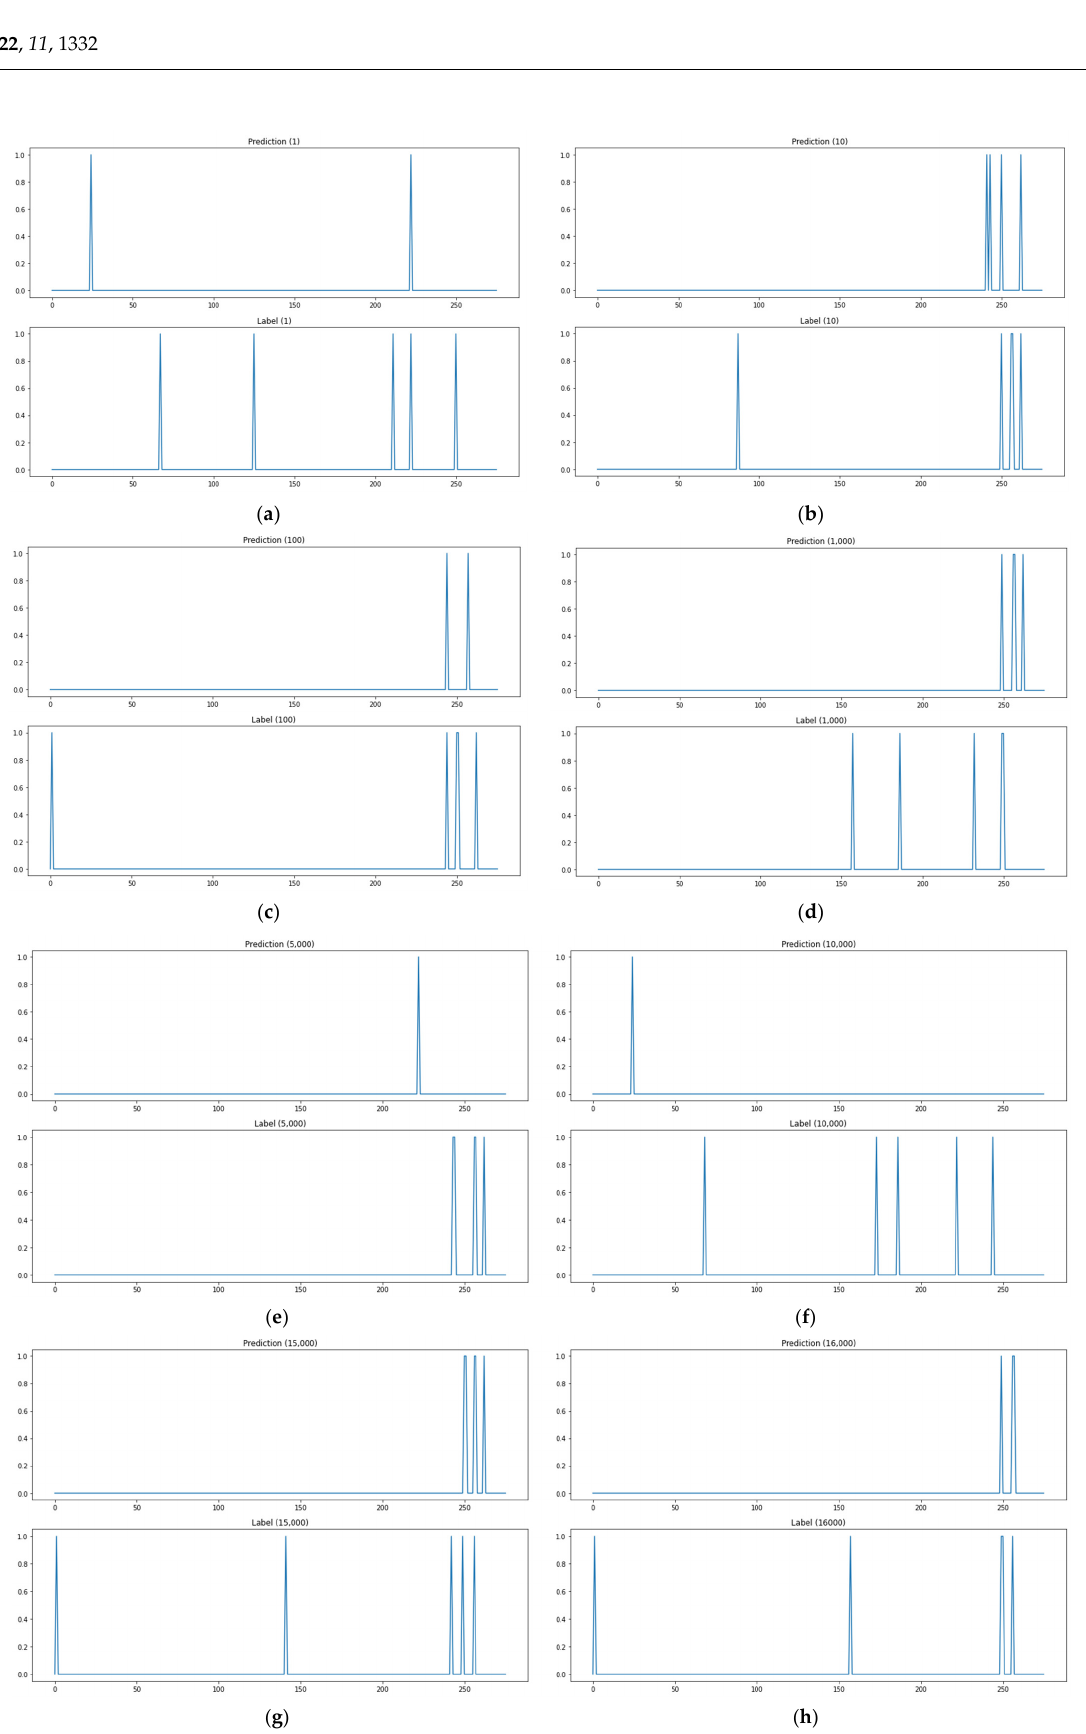
Figure 10. The prediction results of the algorithm adaptation method based on kNN classification. ( a ) Test data 1. ( b ) Test data 10. ( c ) Path test data 100. ( d ) Path test data 1,000. ( e ) Path test data